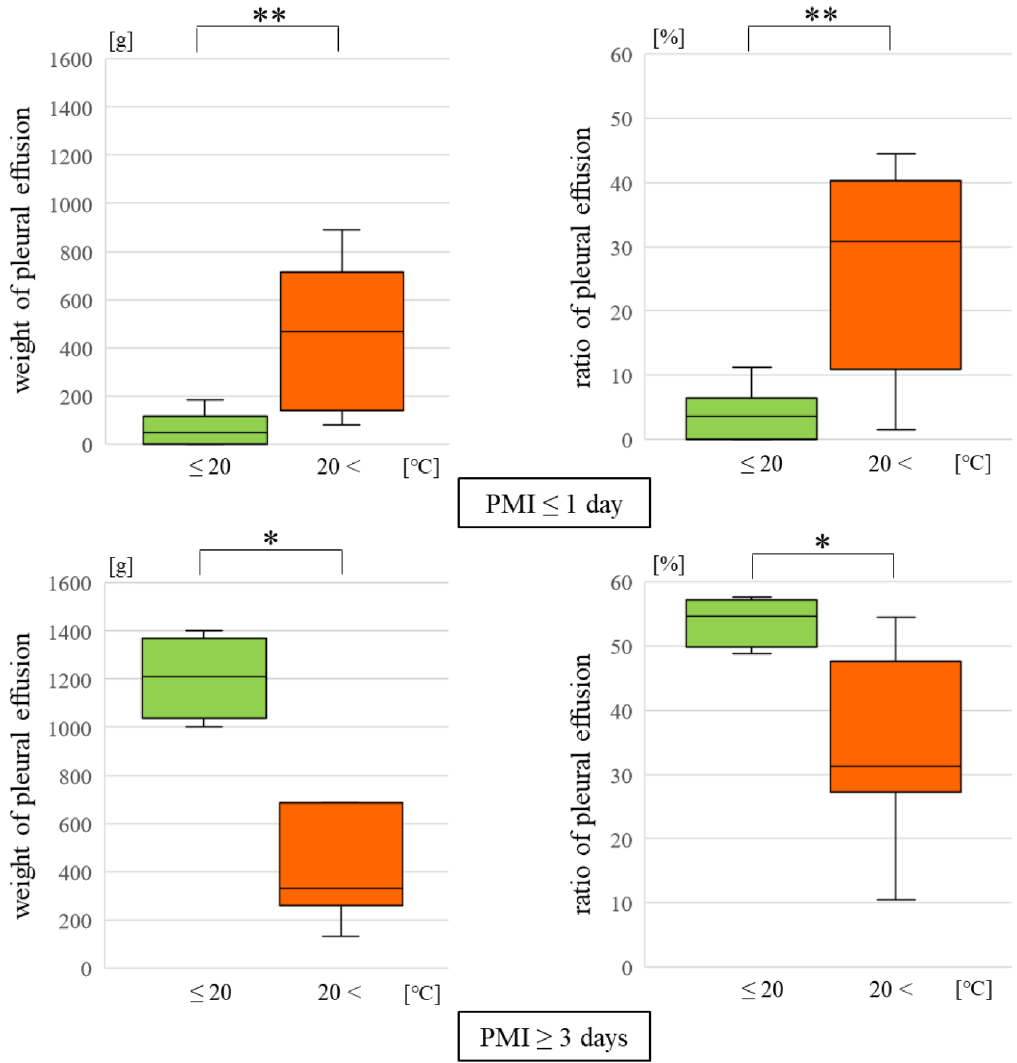
Figure 6. Comparing the weight and the ratio of pleural effusion for different water temperatures in the seawater